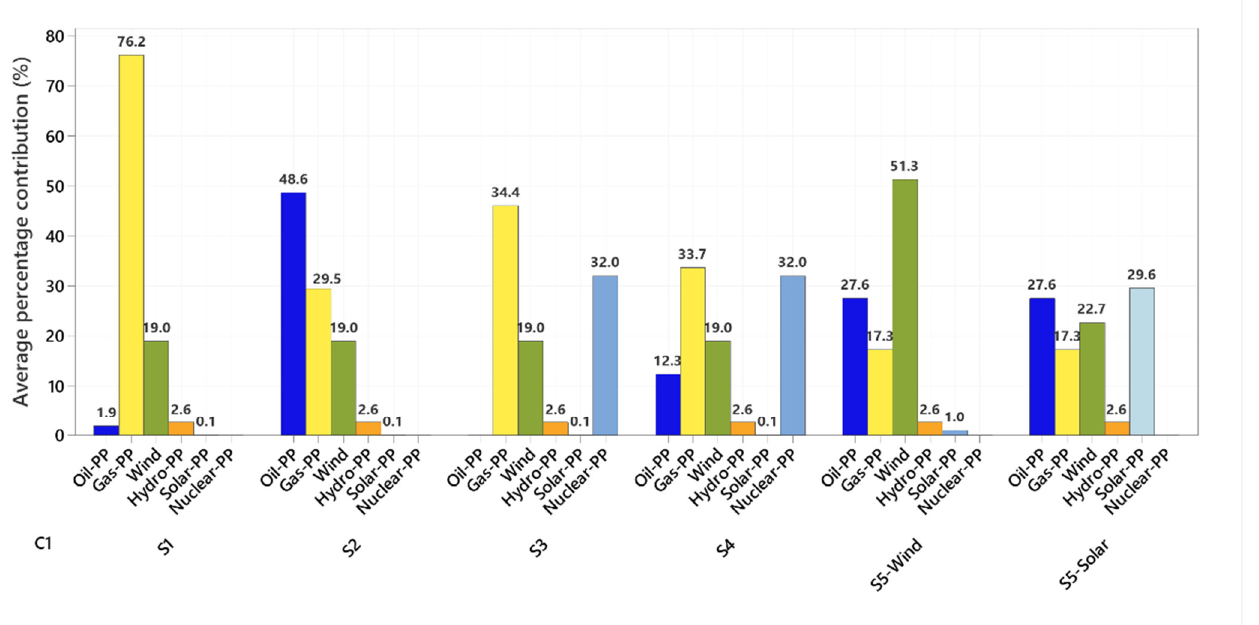
Figure 11. Balance of electricity production of all power plants for fifth scenario, solar case.